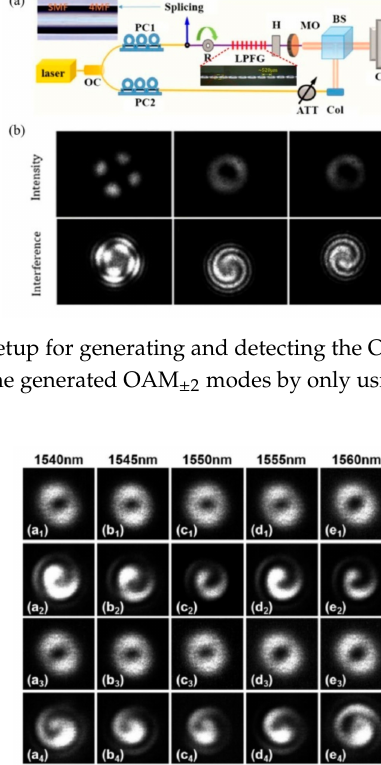
Figure27. Mode intensities ( a 1 – e 1 ) and ( a 3 – e 3 ), interference patterns ( a 2 – e 2 ) and ( a 4 – e 4 ) of the generated OAM ± 1 modes via acoustically-induced fiber grating (AIFG) at di ff erent resonant wavelengths